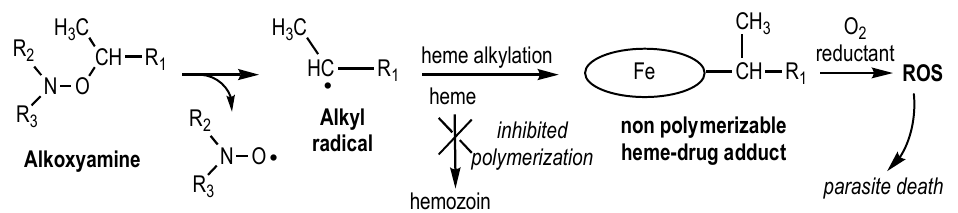
Figure 1. Expected alkylation of heme after homolysis of alkoxyamines, leading to a lethal oxidative stress within blood parasites (the oval stands for the porphyrin macrocycle).